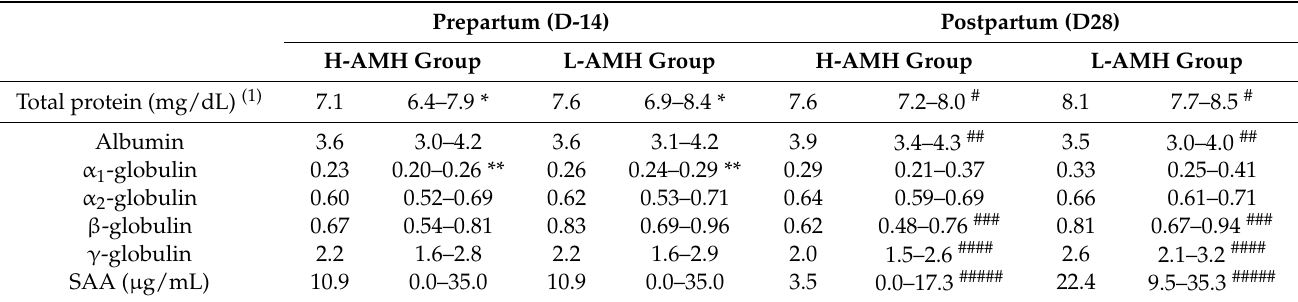
Table 4. Results of serum protein fractions and serum amyloid A (SAA) concentration of H- and L-AMH cows in pre- (D-14) and postpartum (D28) periods (mean and 95%CI).